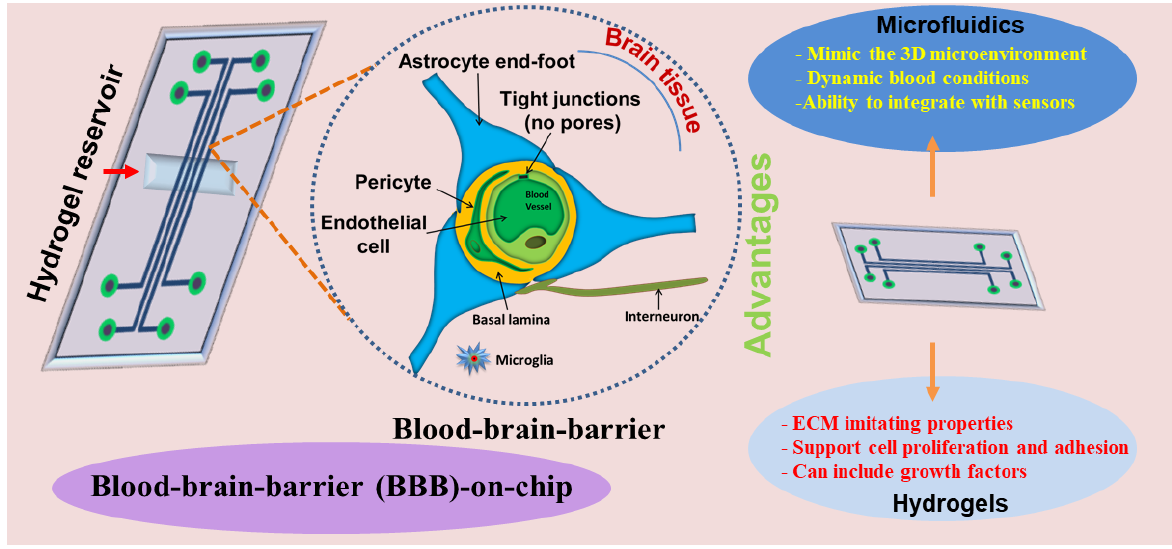
Figure 1. Overview of the hydrogel-based BBB microfluidic model.